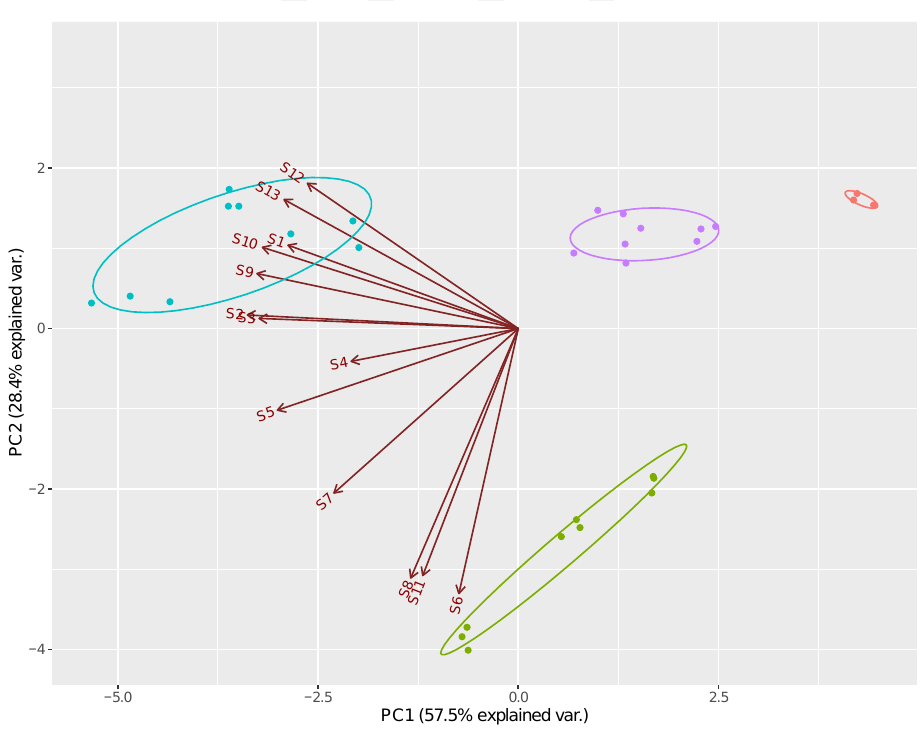
Figure 5. PCA map based on QCM sensor electrodes coated with 13 MISGs.